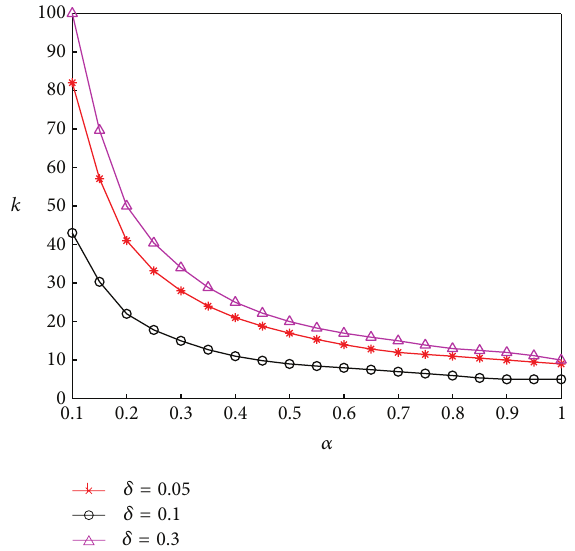
Figure 12: Correlation between 𝑘 and 𝛼 with given different 𝛿 .